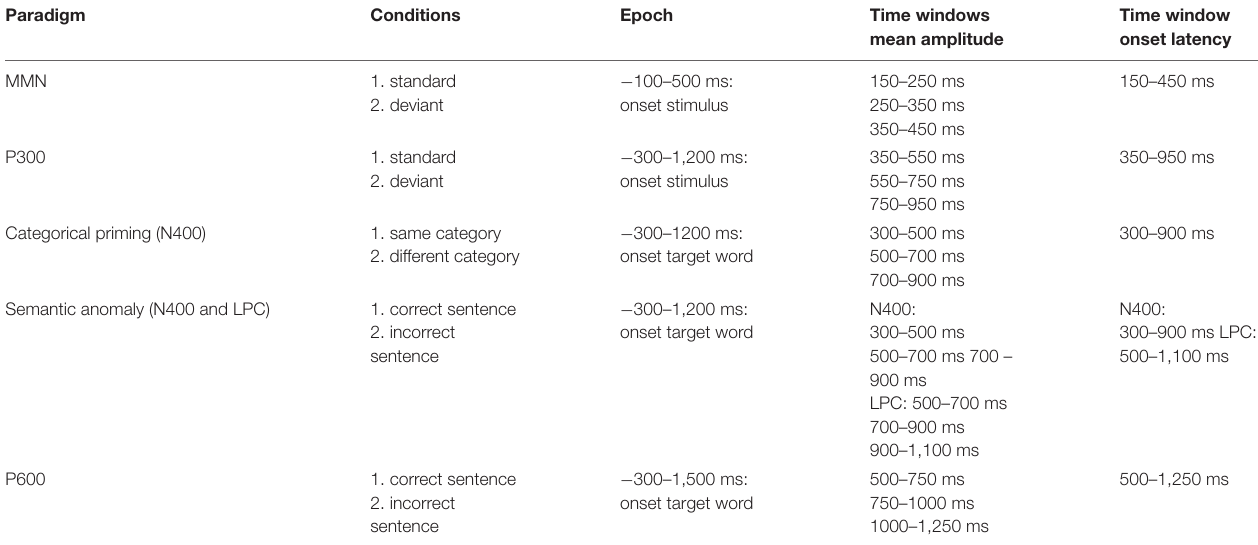
TABLE 1 | The two conditions, the time window of the epoch, and the time windows of the mean amplitude and onset latency for each paradigm.